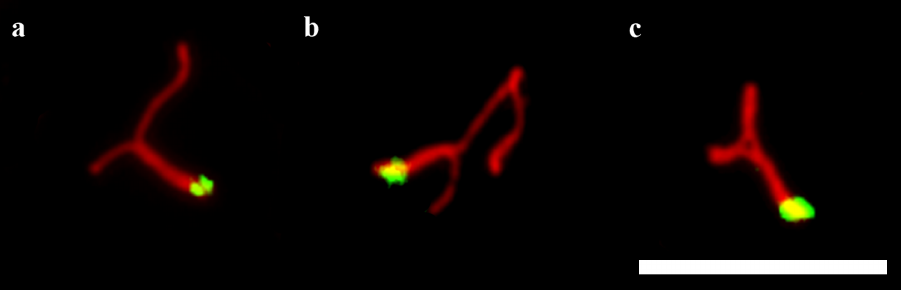
Figure 4. Synaptic configurations of the heteromorphic SC 19. a synapsis in the proximal regions b the longer element showing foldback self-synapsis c completely paired forming a T-shaped configuration. Scale bar: 5